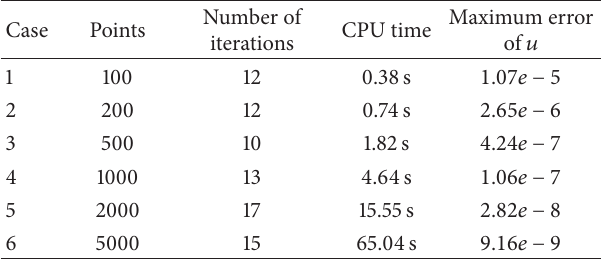
Table 4: Comparison of different grid